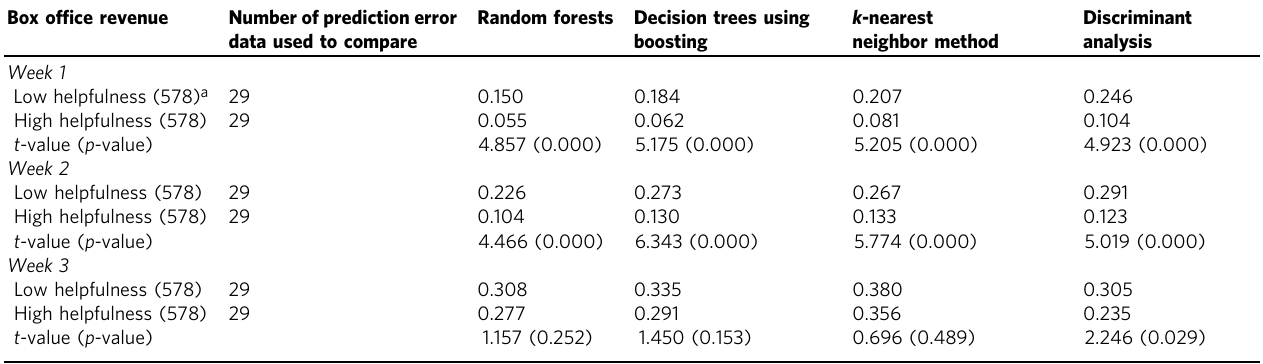
Table 10 t -test of the difference in prediction error among machine learning methods for high and low reviewer helpfulness